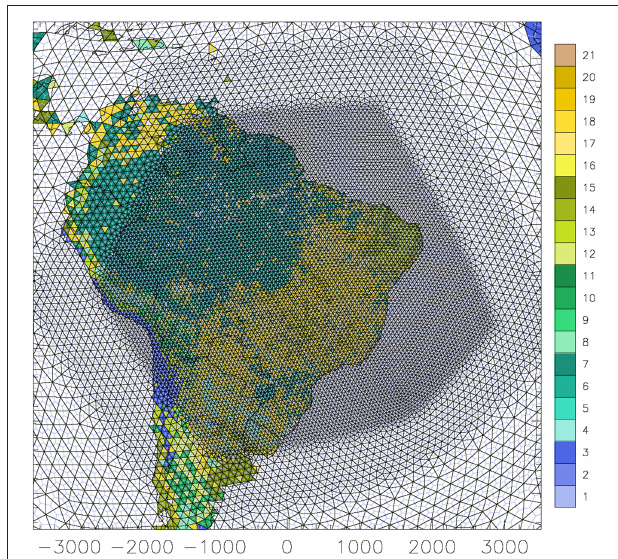
FIGURE 1 | Model domain and spatial grid structure and surface